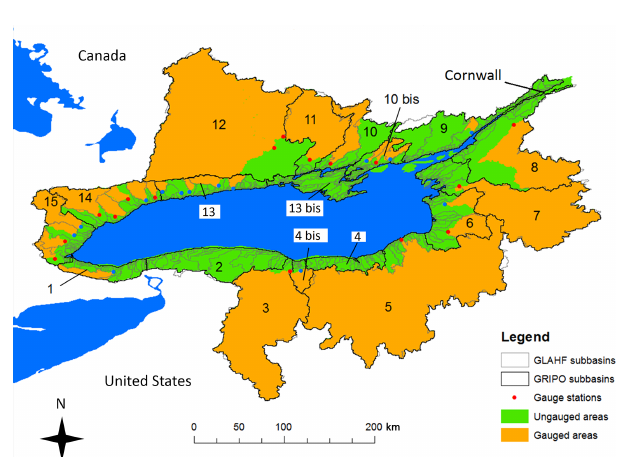
Figure 2. GRIP-O spatial framework: Lake Ontario subbasin delin- eation (GRIP-O subbasins). GLAHF subbasins are from the Great Lakes Aquatic Habitat Framework (Wang et al., 2015). Dots (blue for natural flow regimes and red for regulated regimes) are the most- downstream flow gauges (i.e., the main tributaries’ gauges which are closest to Lake Ontario’s shoreline) selected for model calibra-